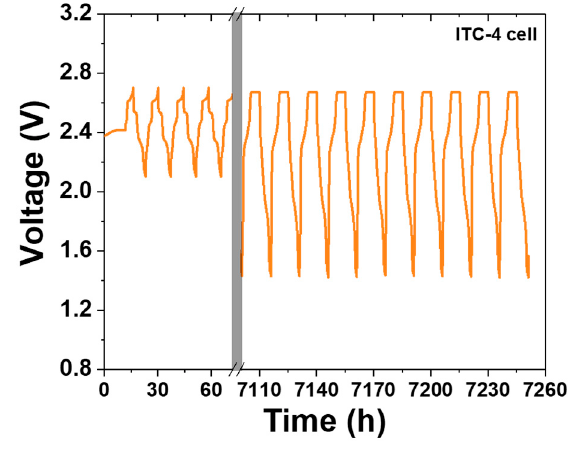
Figure 6. Voltage–time profile of ITC-4 cell for approximately 7200 h.